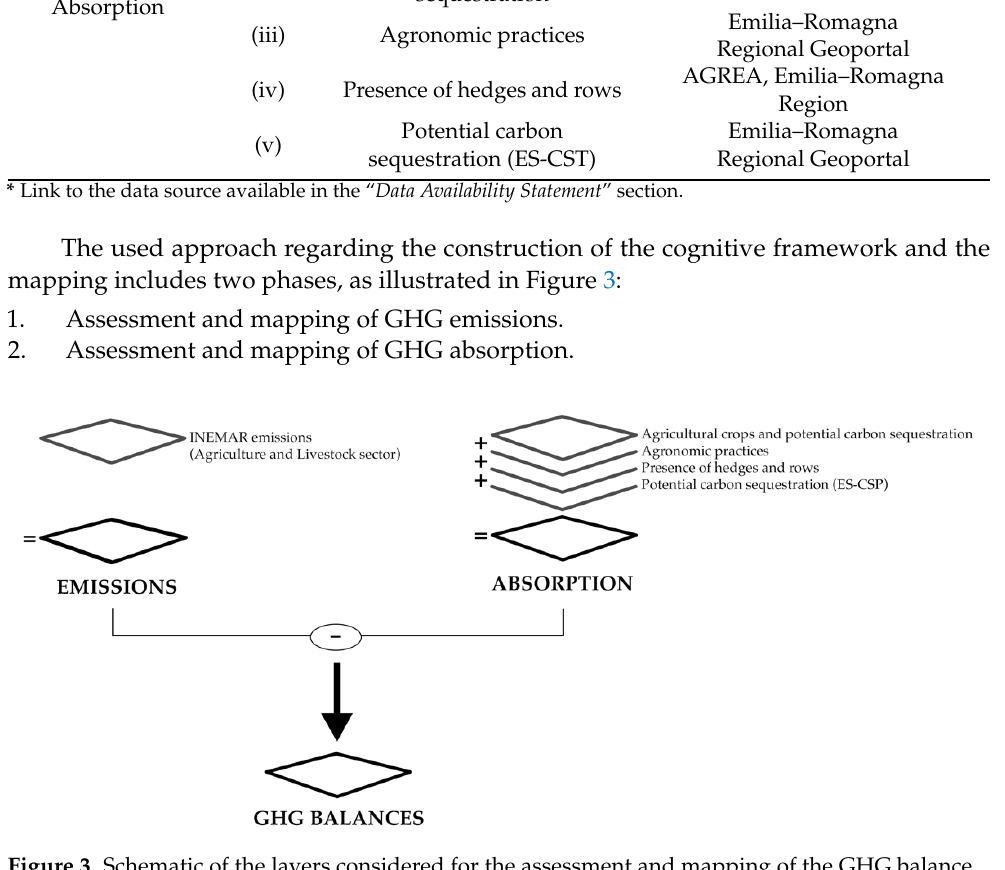
Figure 3. Schematic of the layers considered for the assessment and mapping of the GHG balance. These steps were developed using different spatial criteria to quantify different